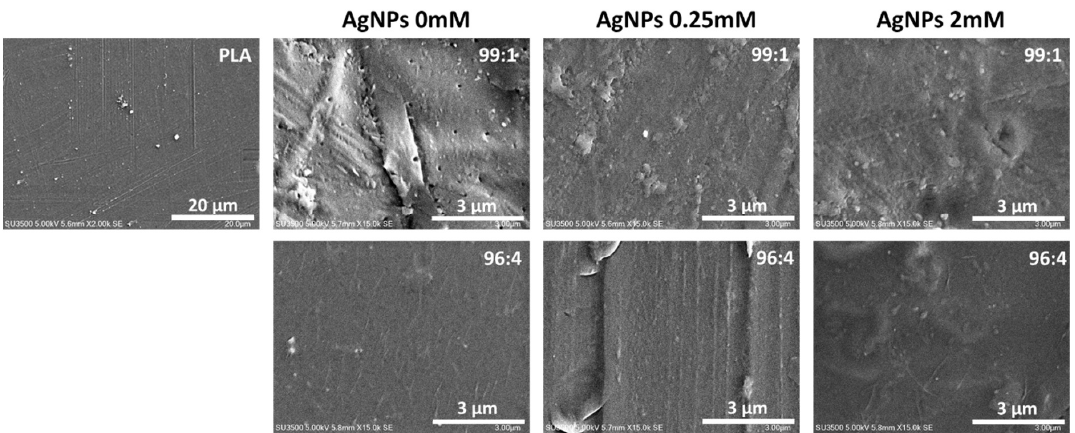
Figure 3. Scanning electron microscopy (SEM) micrographs of PLA (2000×) and composites with CCNF and CCNF/AgNPs (15000x).